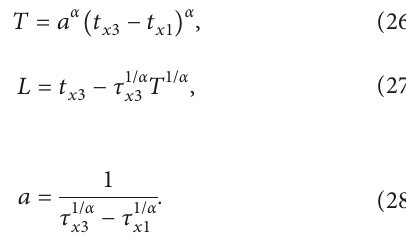
10 , τ 50 , and τ 90